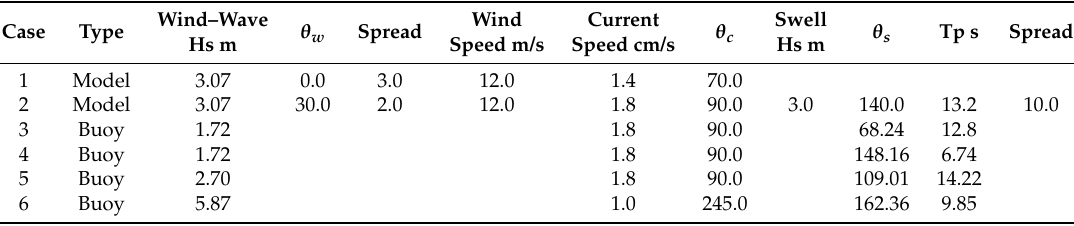
Table 1. Wave, wind and current parameters used for the Doppler spectra simulations. The buoy data are not separated into wind–waves and swell but their peak period and direction are included in the swell